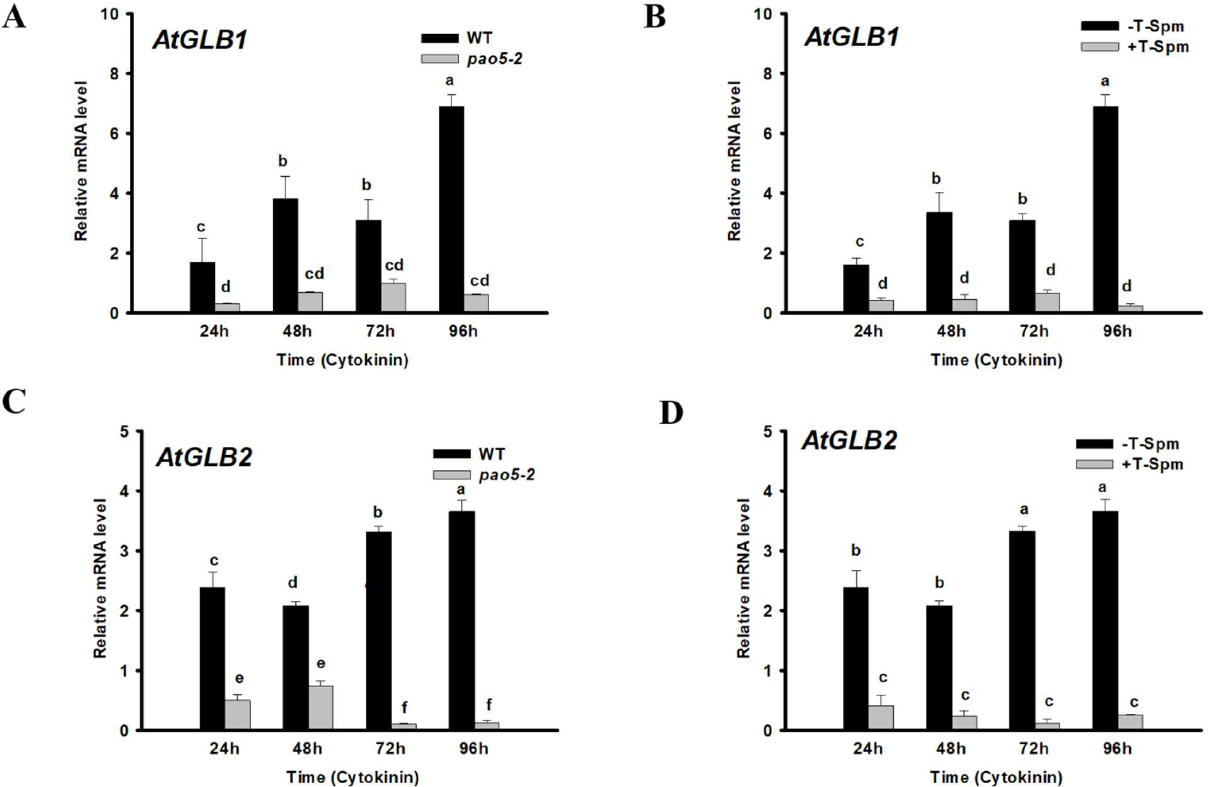
Figure 3. Expression of genes coding the class 3 haemoglobins AtGLB1 ( A , B ) and 2 ( C , D ) in wild-type (WT), pao5-2 mutant, and T-Spm-treated/untreated wild-type (+ − T-Spm) Arabidopsis roots induced to regenerate shoots. Samples taken at 24, 48, 72, and 96 h after cytokinin induction represent the mitotic pause (24 h), organ conversion (48 h), early (72 h) and late (96 h) shoot promeristem phases. The mRNA levels of the UBIQUITIN 1 (At3G52590) and PP2A3 (At1G13320.1) genes were used for gene expression normalization. The mRNA level of the untreated root tissue was used as reference (relative mRNA level: 1). Data were averaged from three independent biological experiments with three technical replicates each. Standard errors are shown on the columns. The significance of difference between sets of data was determined by one-way analysis of variance (ANOVA) following Duncan’s multiple range tests; a p -value of less than 0.05 was considered significant. Different letters indicate significant